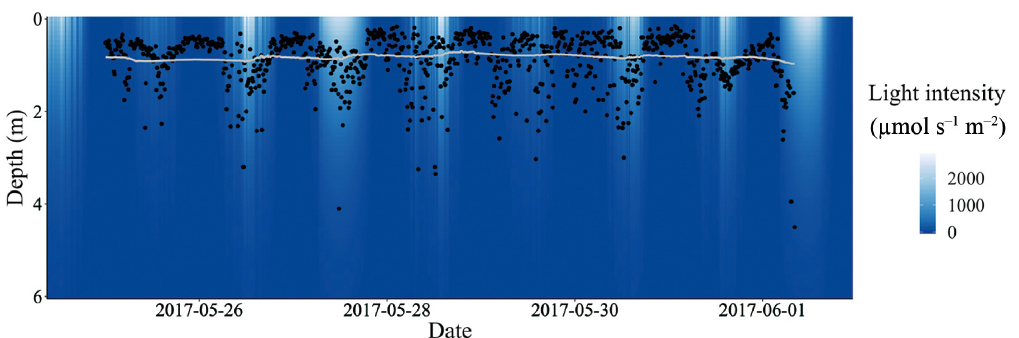
Fig. 5. Observed vertical distribution (black dots) of Salmo trutta , fish 220 (1 mobile louse at the initiation of the experiment, see Table 2), after data filtration (see Section 2.4). Grey line: the vertical distribution predicted by the chosen fitting model (Table 3) for the same individual. The data has been retransformed from log to normal distribution